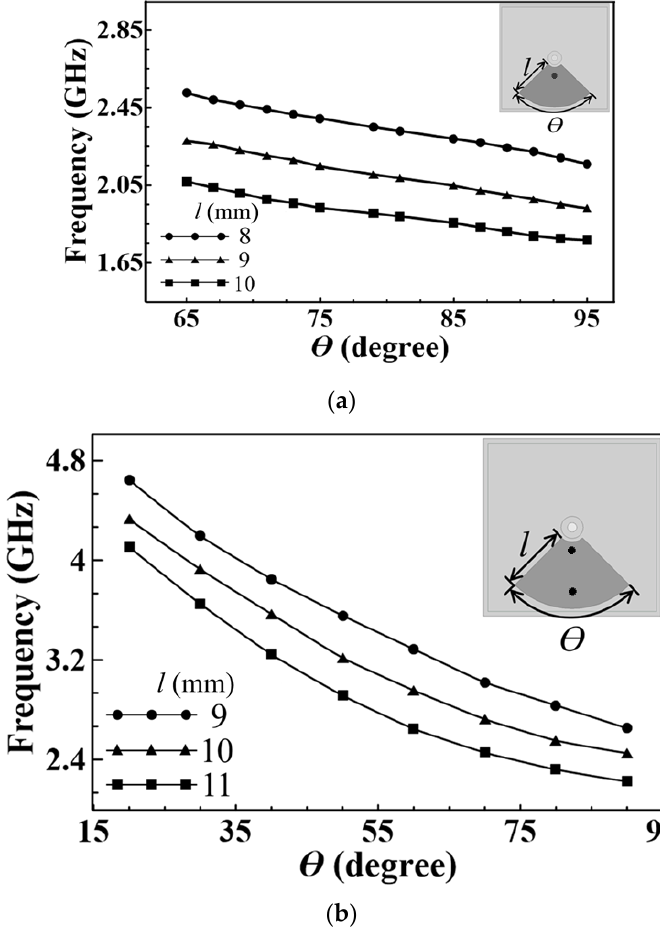
Figure 2. The resonance frequency as a function of the arc angle, θ , of the embedded fan-shaped patch for several side dimensions ( l ) with ( a ) one and ( b ) two shorting vias.